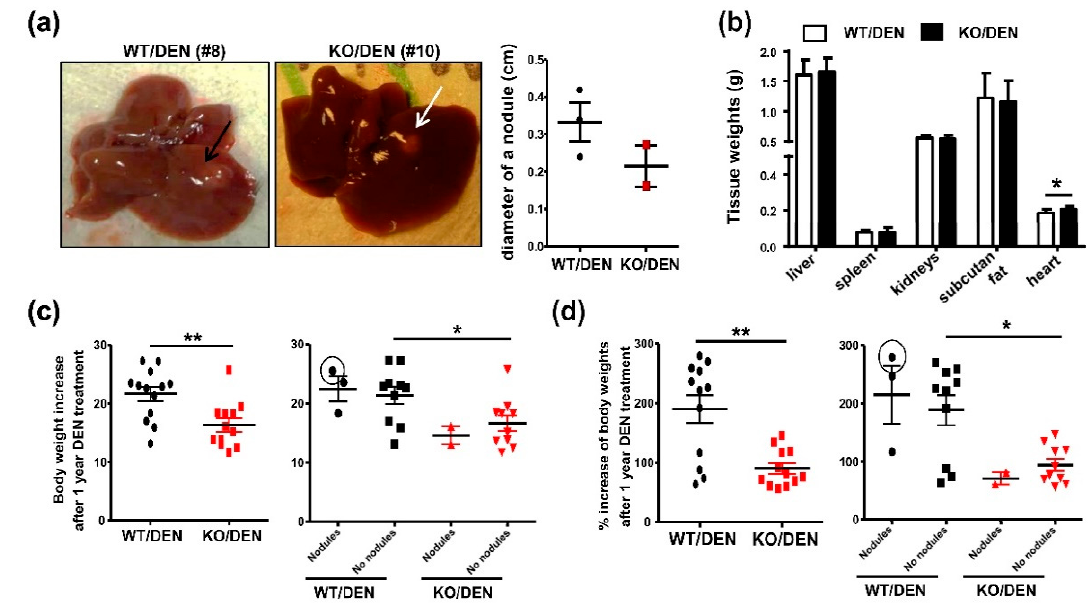
Figure 1. Mice at 3–5 weeks old were treated with a single dose of 10 mg/kg DEN and sacrificed 12 months later. Tissue weights and the diameter of any observable nodules were measured. ( a ) Left panel shows pictures of a small nodule of DEN-treated WT (Mouse #8, indicated by a black arrow) and KO (Mouse #10, indicated by a white arrow). Right panel shows a plot of nodule diameters of 3 DEN-treated WT mice and 2 of DEN-treated KO mice. ( b ) Absolute liver, spleen, kidneys, subcutaneous fat, and heart weights. ( c ) An increase in body weight in grams after one-year DEN treatment obtained from total number of mice (left) and mice with ‘Nodules’ or ‘No nodules’ (right). ( d ) % increase from starting body weights obtained from total number of mice (left) and mice with ‘Nodules’ or ‘No nodules’ (right). The value with a black circle was from DEN-treated WT Mouse #8. Data are mean ± SEM, N = 12–13 for ( b – d ). * p < 0.05, ** p < 0.01 with Mann-Whitney U tests.